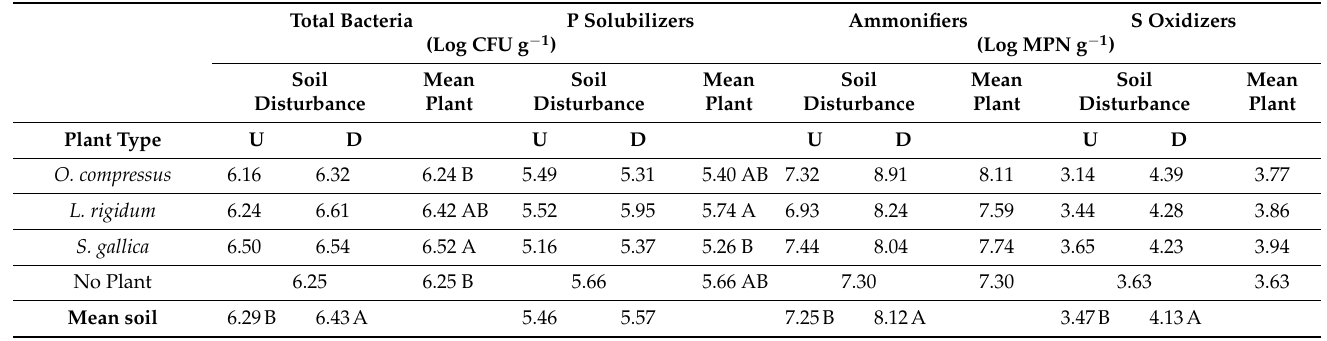
Table 3. Effect of previous type of plant and soil disturbance on soil microbial functional group count of total bacteria, phosphorus (P) solubilizers, ammonifiers and sulfur (S) oxidizers after wheat growth. Total